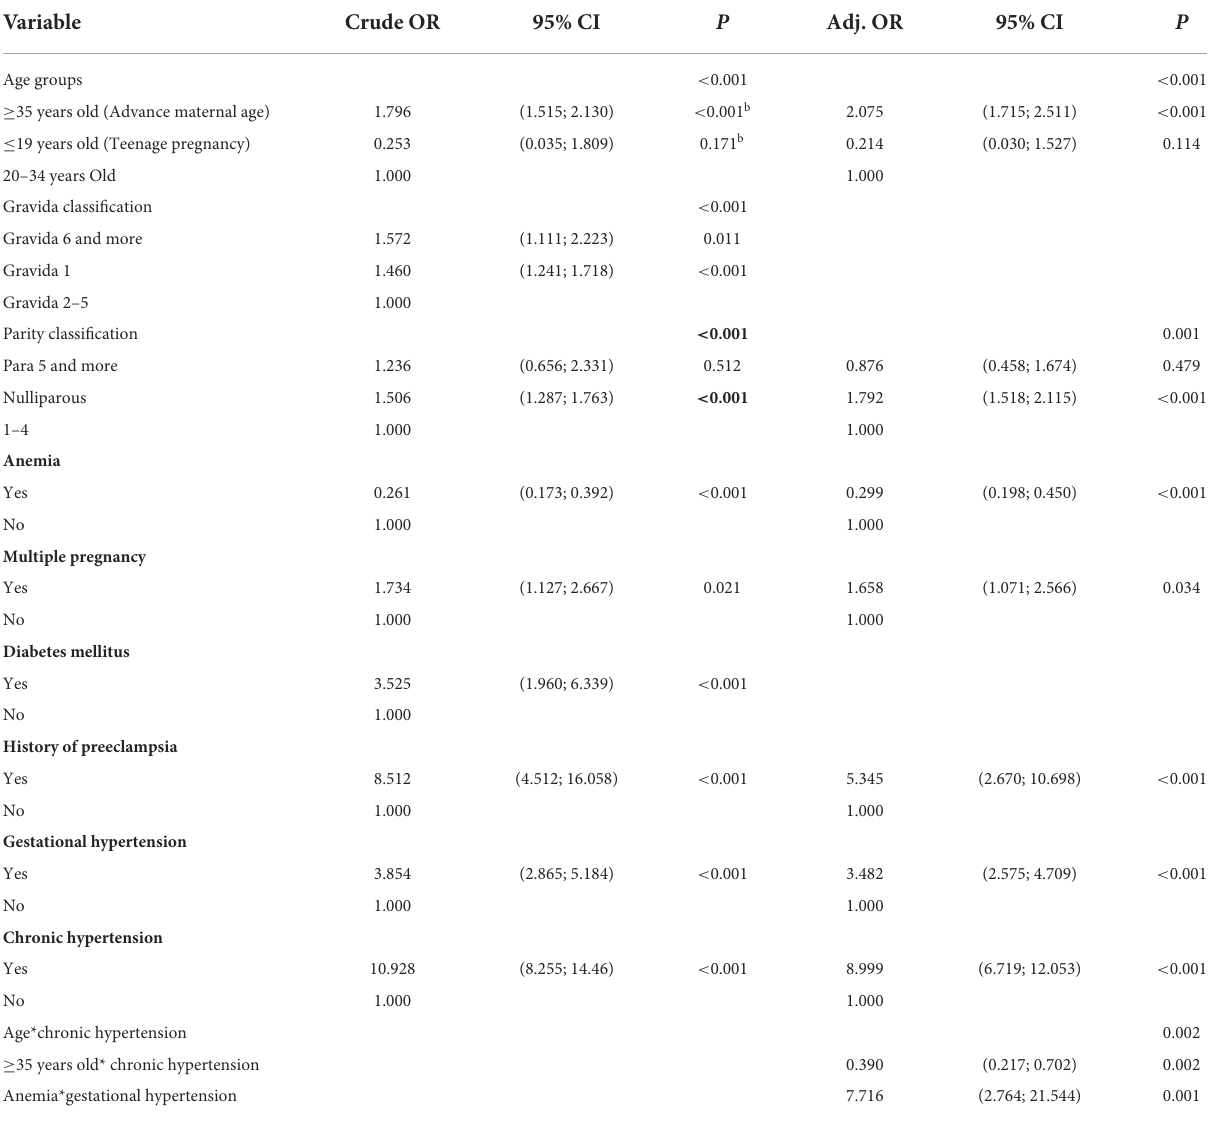
TABLE 2 Factors associated with preeclampsia.